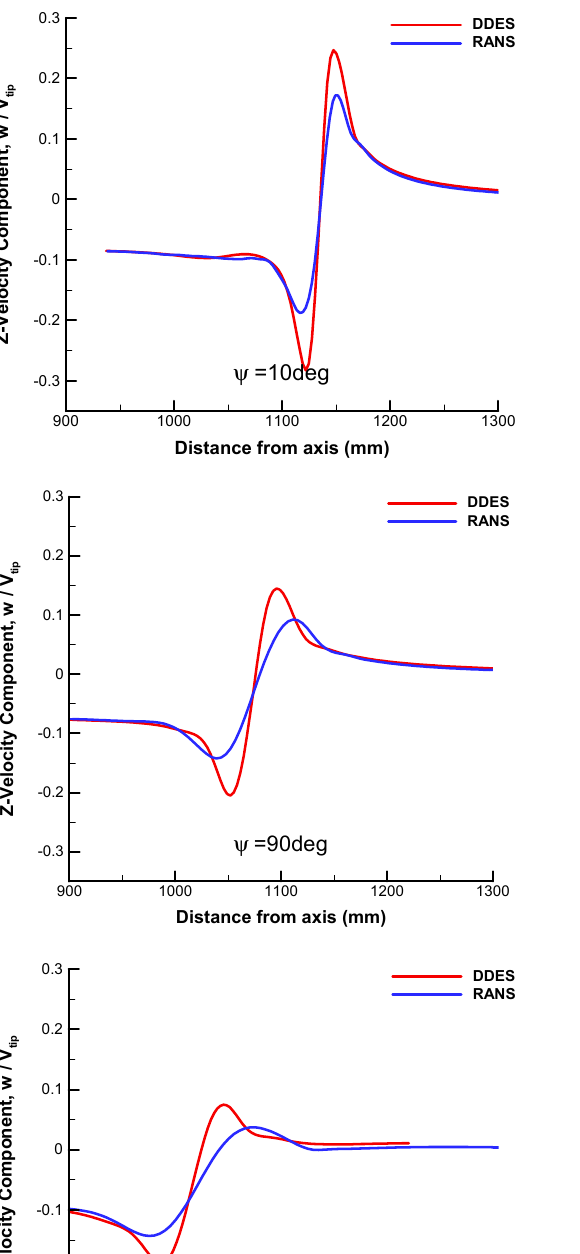
Figure 16. Comparison of cross-section vorticity distribution obtained by RANS and DDES. ( a ) Y = 0 section, ( b ) X = 0 section.